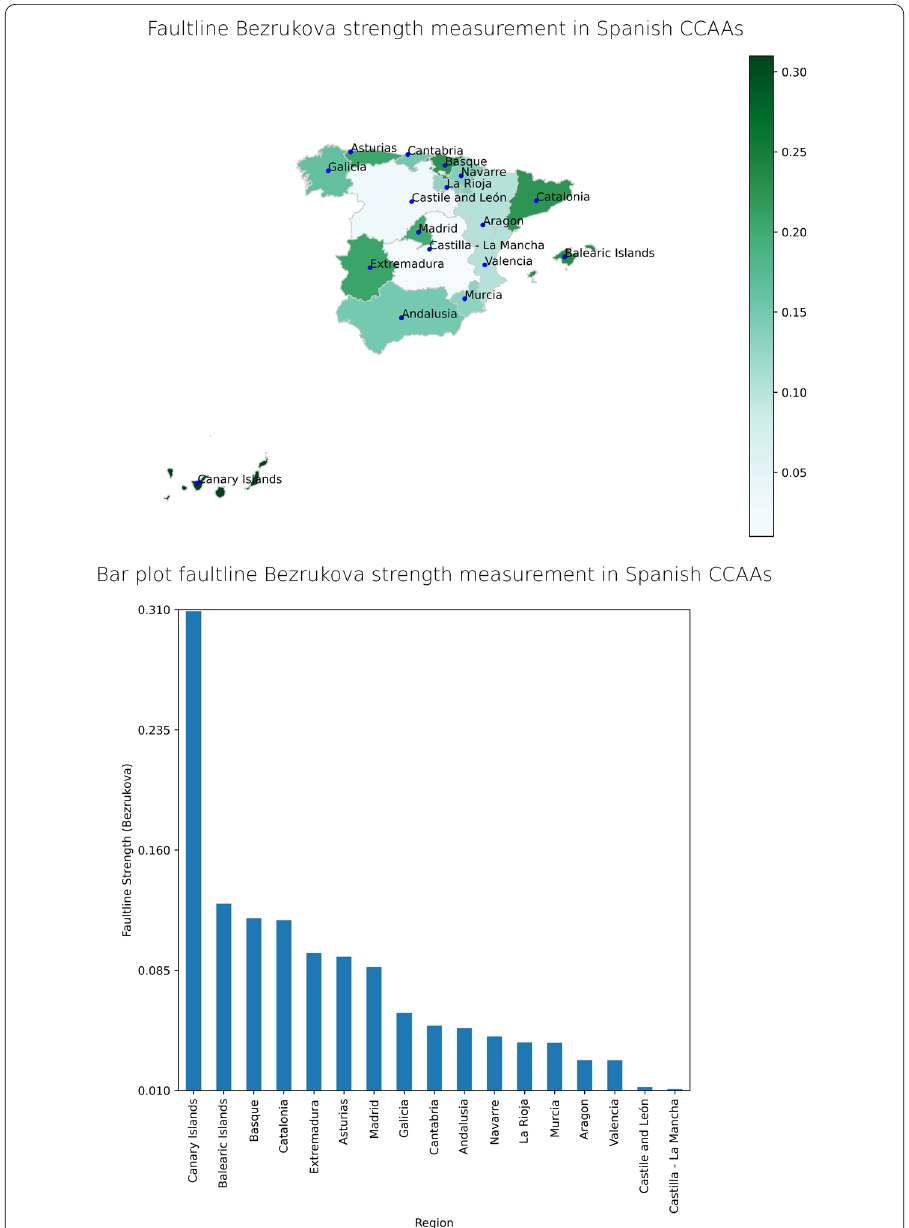
Figure 5 Faultline strength analysis